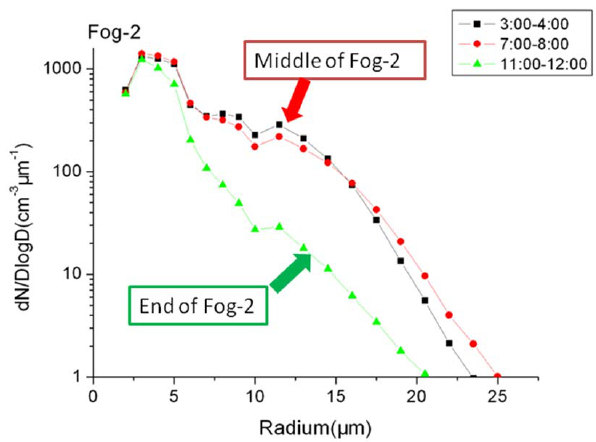
Fig. 8. The evolution of the size distribution of fog droplets in the Fog-2 period.